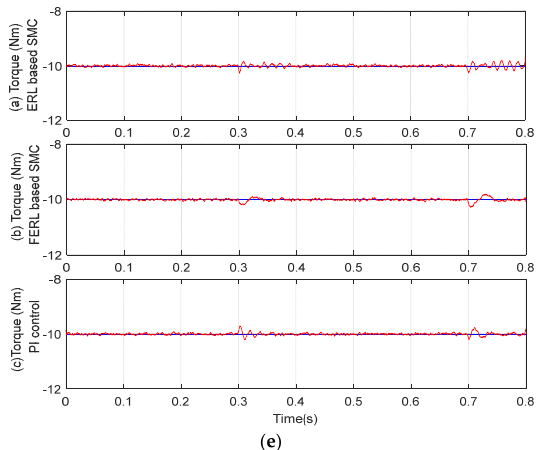
Figure 9. Simulation results under grid fault condition comparing three different approaches: ( a ) Rotor currents; ( b ) Stator currents; ( c ) Stator active power performances; ( d ) Stator reactive power performances; ( e ) Generator torque.